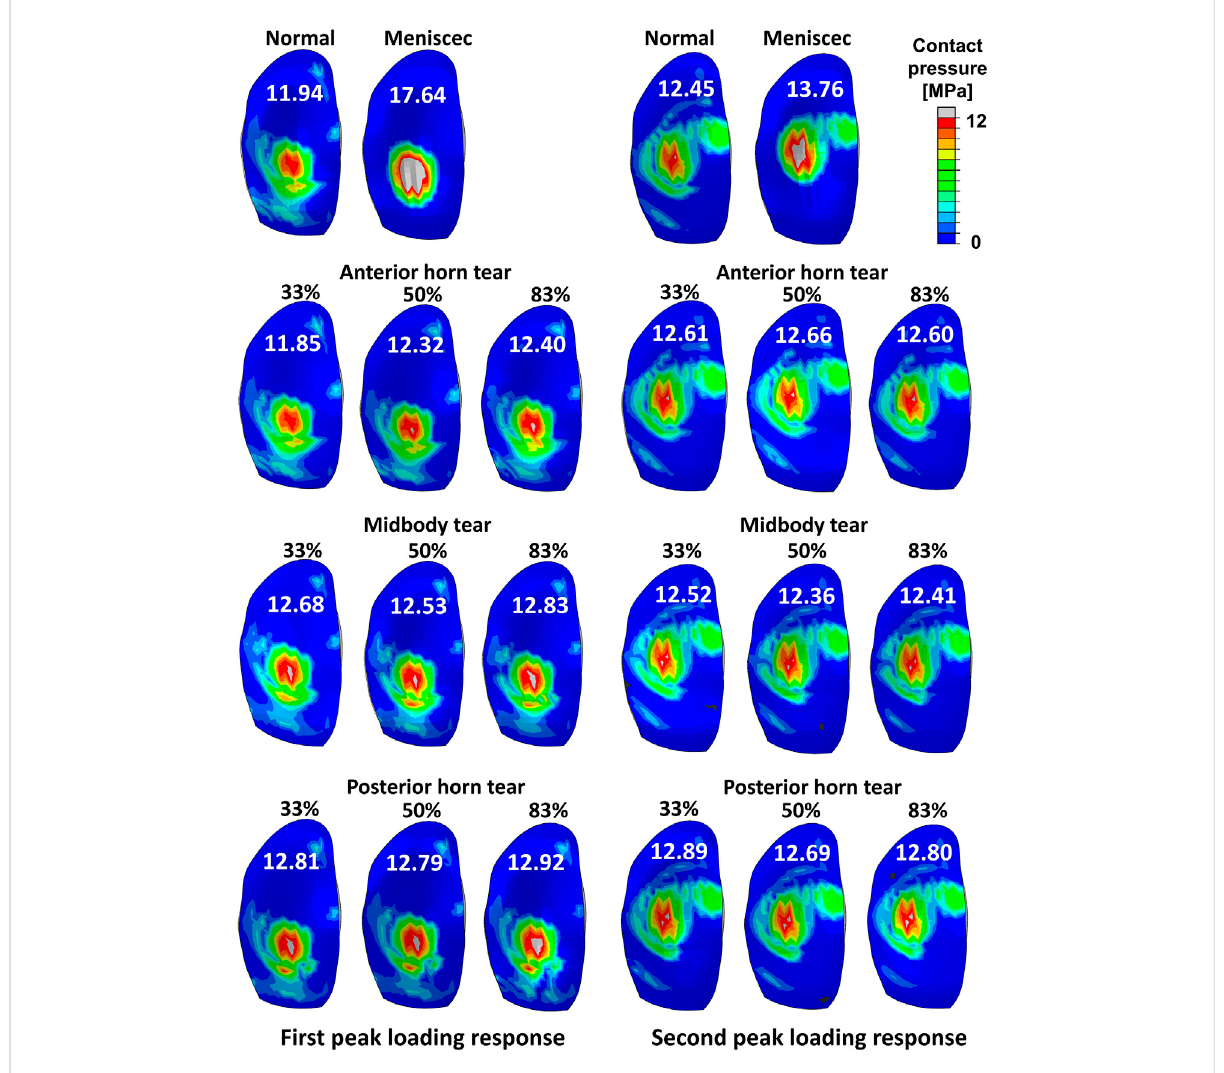
FIGURE 6 Resultsofthecontactpressuredistributionandresultantpeakvalues(whitewords)occurringonthemedialtibialcartilageobtainedbyahealthy intact knee, total meniscectomy knee, and radial tears during the maximum weight acceptance and push-off.